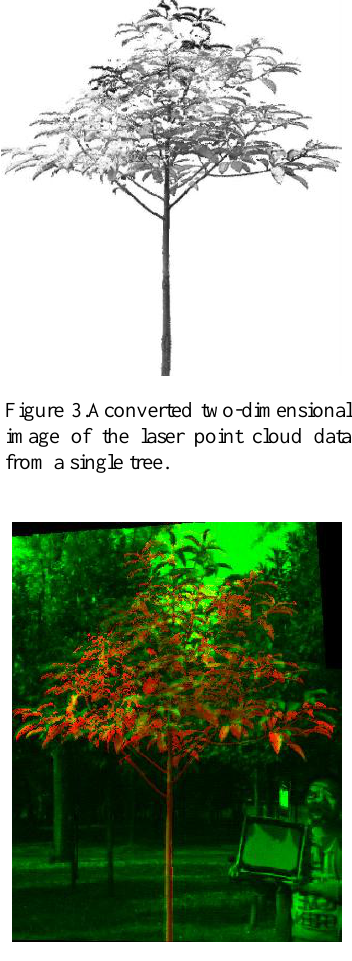
Figure 4.A Pseudo-color image of a pair of co-registered data. Here laser point cloud data is shown in red, and imaging data are given in green.